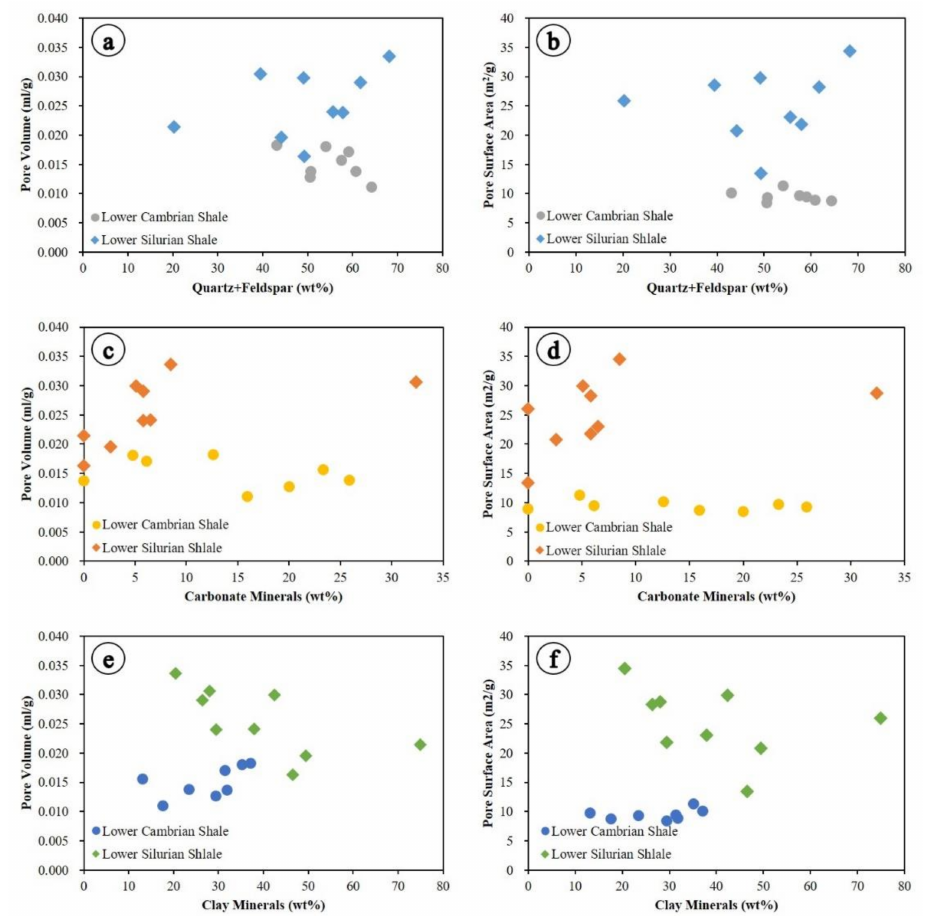
Figure 12. Scatter charts of correlations between pore properties and minerals. ( a ) relationship between pore volumes and Quartz + Feldspar; ( b ) relationship between pore surface areas and Quartz + Feldspar; ( c ) relationship between pore volumes and Carbonate minerals; ( d ) relationship between pore surface areas and Carbonate minerals; ( e ) relationship between pore volumes and Clay minerals; ( f ) relationship between pore surface areas and Clay